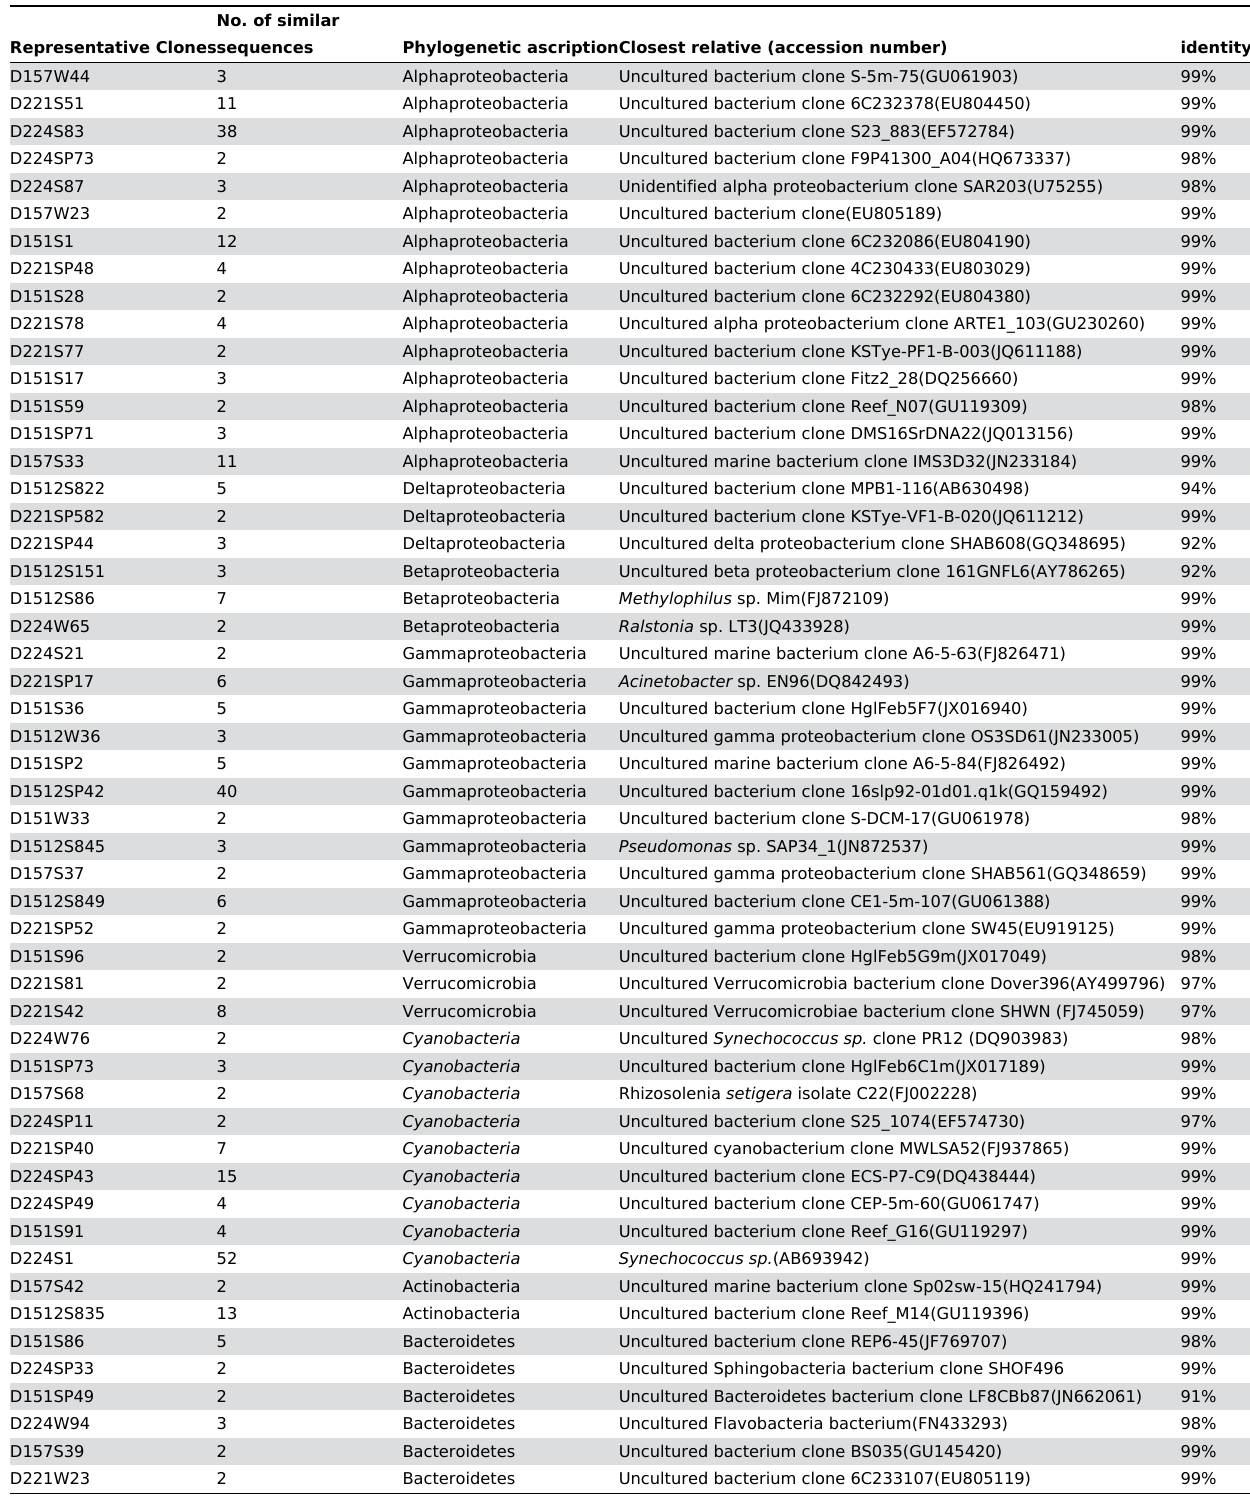
Table 3. Phylogenetic affiliation of library clones obtained from coastal waters of the South China Sea as deduced from BLAST searched.